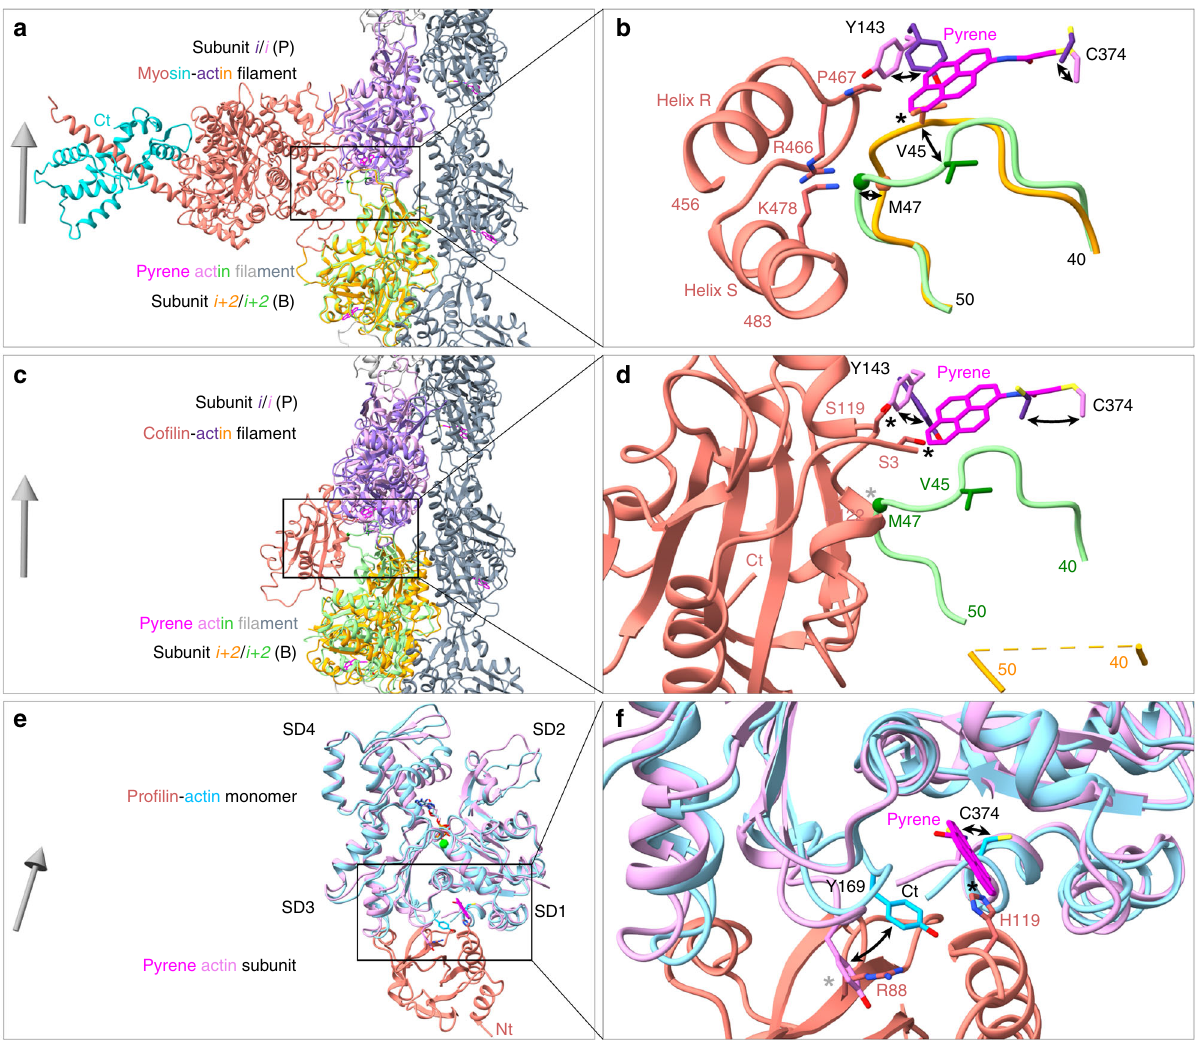
Fig. 6 Ribbon diagrams showing the in fl uence of pyrene labeling on the interactions of myosin and co fi lin with actin fi laments and of pro fi lin with actin monomers. Gray arrows show the fi lament orientation with arrowheads pointing to the pointed end. Black curved arrows show conformational changes. Black stars label strong clashes; gray stars mark local conformational changes that cause minor or no clashes. a , c , e Overviews; b , d , f simpli fi ed close-up views. a , b Superimposition of an ADP-actin fi lament decorated with myosin-Ib (PDB ID: 6C1D) on our ADP-pyrenyl-actin fi lament. All the C α atoms of subunit i in these two fi laments were used for the superimposition. The presence of pyrene would cause two steric clashes with myosin: rotation of the side chain of Y143 of actin would clash with the cyclic side chain of P467 of the myosin heavy chain; and the backbone of actin M47 clashes with the side chains of myosin R466 and K478. Binding of myosin to pyrenyl-actin fi lament is likely to displace pyrene partially from its hydrophobic pocket. c , d Superimposition of a co fi lin-decorated ADP-actin fi lament (PDB ID: 5YU8) on our ADP-pyrenyl-actin fi lament. The C α atoms of residues in subdomain 3 of subunit i were used for the superimposition. The presence of pyrene would cause two steric clashes with co fi lin: the side chain of actin Y143 clashes with the side chain of co fi lin S119; and the pyrene group clashes with the side chain of co fi lin S3. Binding of co fi lin to ADP-pyrenyl-actin fi lament would squeeze part of the pyrene group out of the hydrophobic pocket and displace the D-loop of the neighboring subunit. e , f Superimposition of a pro fi lin-actin monomer complex (PDB ID: 2BTF) on a subunit in our ADP-pyrenyl-actin fi lament using subdomains 1 and 3. The C α atoms of residues in subdomains 1 and 3 are used for their superimposition. The side chain of pro fi lin H119 would clash with the pyrene group. The side chain of actin Y169 could avoid the clash with the side chain of R88 in pro fi lin by rearranging the conformation of the Y169 loop (WH2-binding loop). SD1-4: subdomains homogenized in buffer G, and the mixture dialyzed against buffer G for 2 days at monomers was determined by absorbance at 290 nm using [actin, µM] = 4 °C. After clari fi cation at 4°C in a Beckman Ti70 rotor at 148,229 × g for 2h, the A 290 × 38.5. top 80% of supernatant was gel fi ltered through a Superdex 200 column equili- brated with buffer G. The concentrations of pyrene and actin in the peak tail Labeling ADP-actin fi laments with N-(1-pyrene) iodoacetamide . The bottom fractions were determined by measuring the absorbances at 344 nm (A 344 ) and 290 nm (A 290 ) and using these formulas: [pyrene, µM] = A 344 × 45.5µM/OD and 1/3 of depolymerized actin supernatant was polymerized by dialyzing for 10h against three changes of PL buffer (100mM KCl, 2mM MgSO 4 , 25 mM Tris-HCl, pH 7.5, 0.3mM ATP, 3mM NaN 3 ). During polymerization, bound ATP was hydrolyzed into ADP and phosphate (P i ). Dissociated P i and DTT (from buffer G) were removed during dialysis. The repolymerized actin was diluted to 1mg/mL (23.8 µM) with PL buffer and incubated at 4°C for 36h with 0.15 mM N-(1- pyrene)iodoacetamide from a stock solution of 10mM dissolved in dimethylfor- actin by incubating with 1mM glucose and 5 units/mL hexokinase at room mamide. Labeled actin fi laments were collected by centrifugation, the pellet was